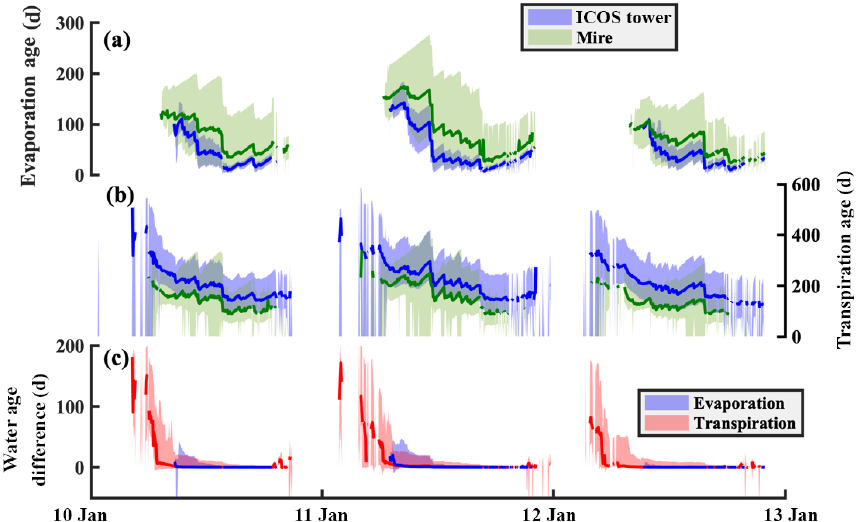
Figure 6. 90% bounds and median values of the (a) estimated soil evaporation water ages at the ICOS tower (blue) and in the mire (green), (b) estimated transpiration water age at the ICOS tower (blue) and in the mire (green), and (c) mean difference of evaporation and transpiration water ages when soil frost is not